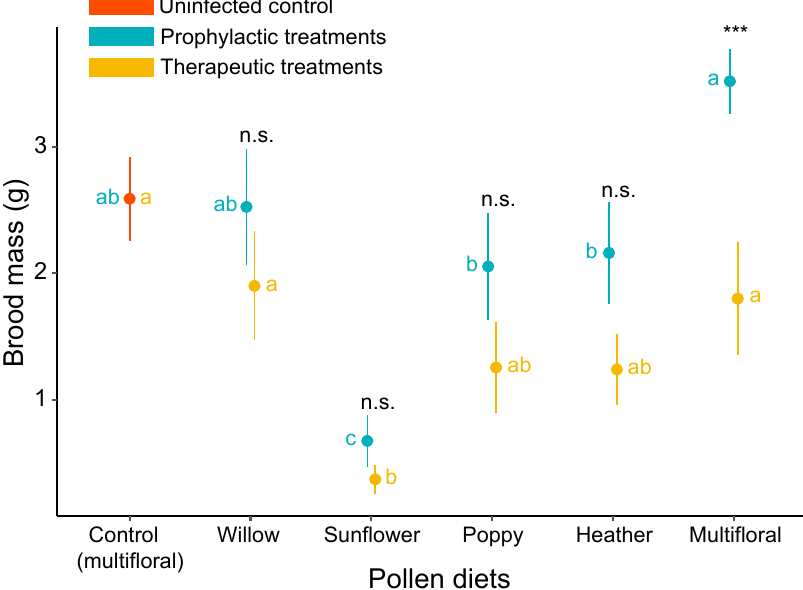
Figure 3. Effects of treatments on the total mass of hatched offspring in B. terrestris micro-colonies. Data in blue represent the prophylactic treatments, data in gold represent the therapeutic treatments, and data in orange represent the uninfected control (i.e., uninfected microcolonies fed on multifloral pollen). Points are mean values of each treatment and error bars indicate the standard error of means. Letters indicate significance at p <0.05; blue letters refer to comparison across pollen diets within prophylactic treatments, gold letters refer to comparisons across pollen diets within therapeutic treatments, and statistical significance code refers to comparison between treatments (prophylactic vs. therapeutic) (n.s., p >0.05; ***, p <0.001). Pairwise comparisons were performed based on a priori